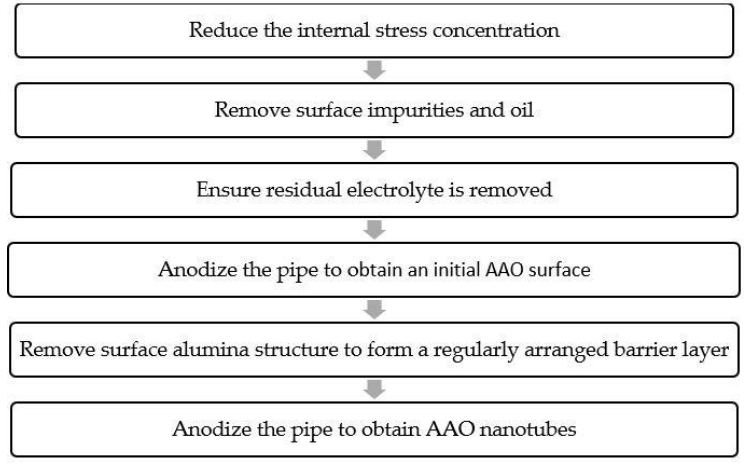
Figure 2. Anodic oxidation treatment procedure for each pipe.